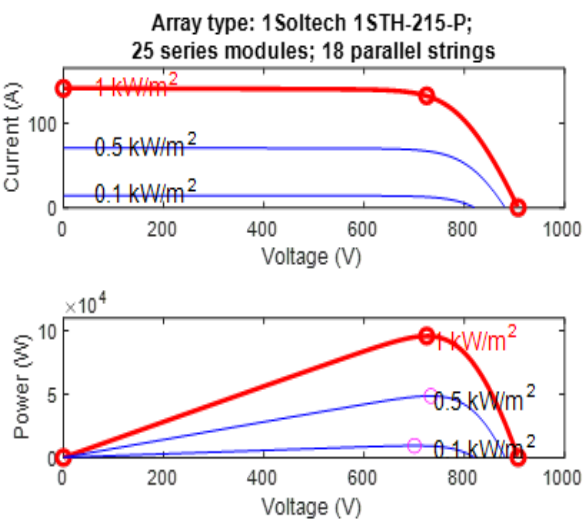
Figure 3. PV array current and voltage with different conditions of irradiation.